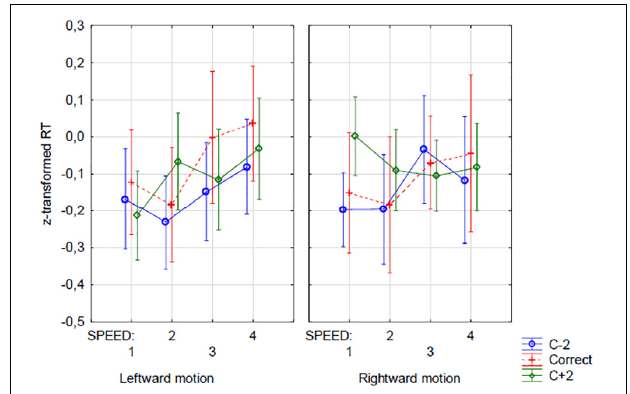
FIGURE 4 | Reaction times. The interaction between DIRECTION OF MOVEMENT , OUTCOME OPTION , and VELOCITY (speed) factors. Blue line, c–2 option; Green line, c + 2 option; correct option (c) additionally plotted with red dashed